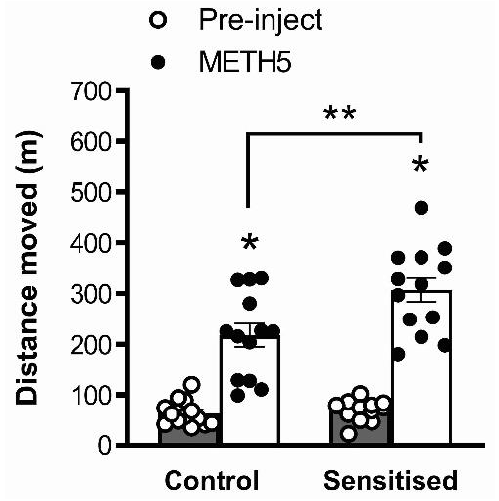
Figure 3. Acute METH-induced locomotor hyperactivity was significantly increased in METH-sensitised mice compared to vehicle-treated controls. * p < 0.05 for difference with pre-injection distance moved; ** p < 0.05 for difference with controls. METH5 = 5 mg/kg METH. n = 13 control mice; n = 13 sensitised mice.